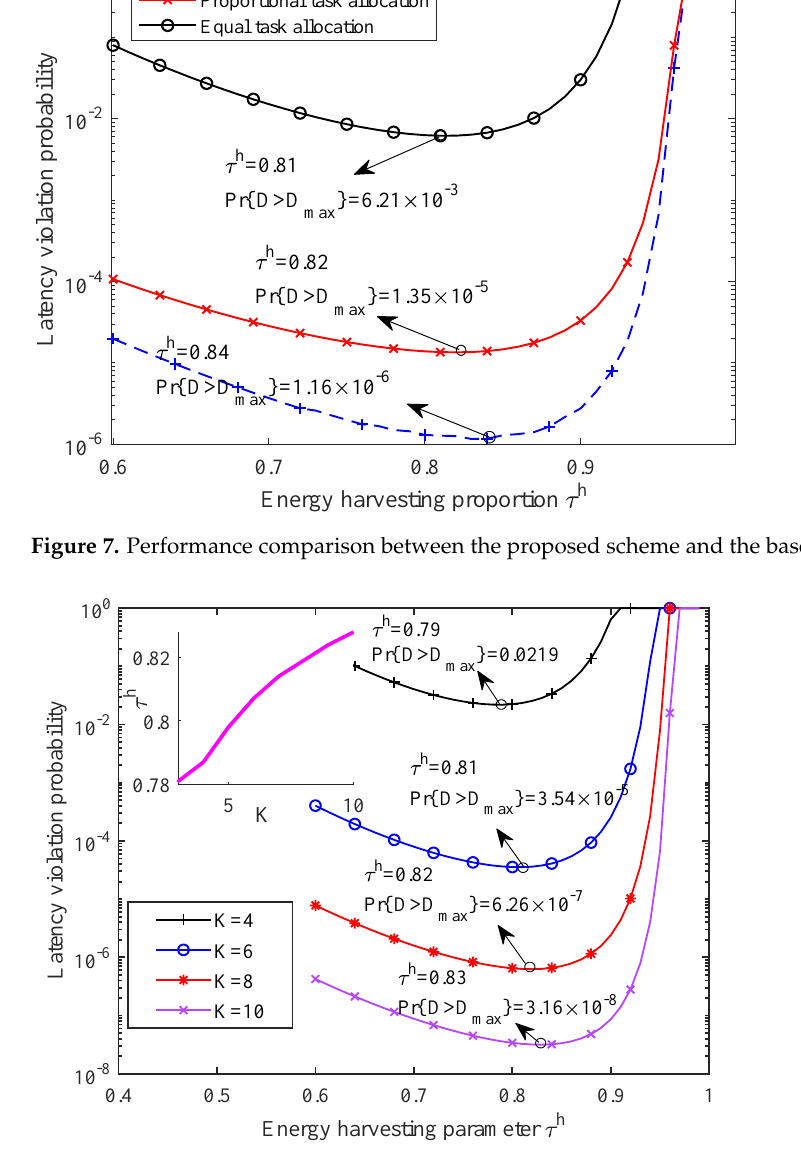
Figure 8. The relationship between network LVP and energy harvesting proportion under a different number of